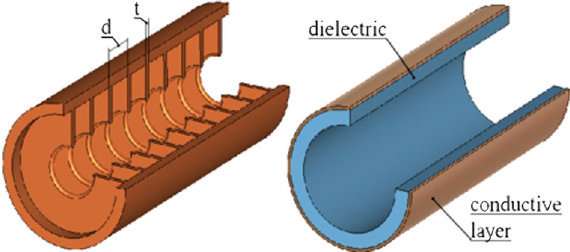
FIG. 1. Supporting structures for slow deflecting waves: periodical iris loaded circular waveguide, left, and dielectric lined waveguide,